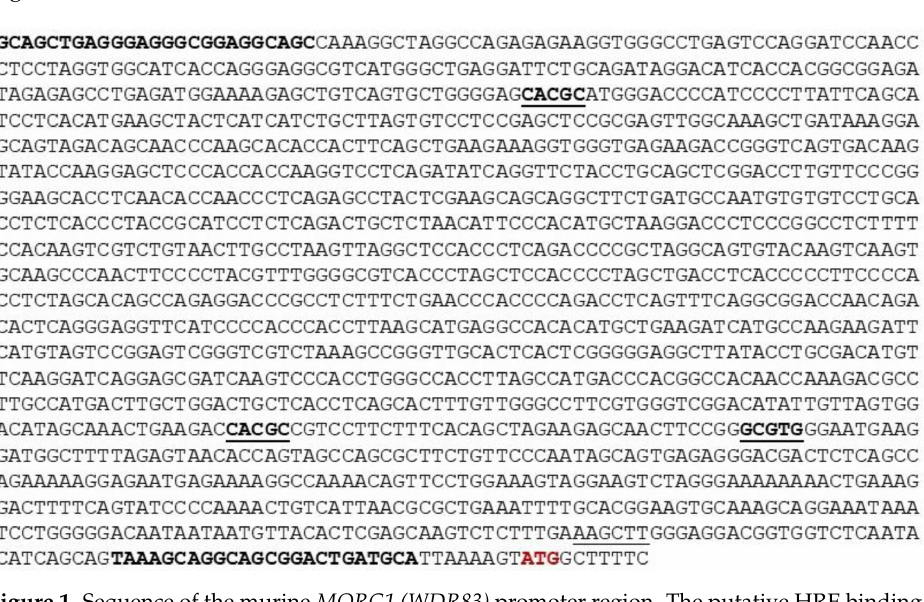
Figure 1. Sequence of the murine MORG1 (WDR83) promoter region. The putative HRE binding sites are underlined in bold. The primers used for amplification of the promoter region are shown in bold. The ATG start codon is shown in red. The internal HindIII restriction site is